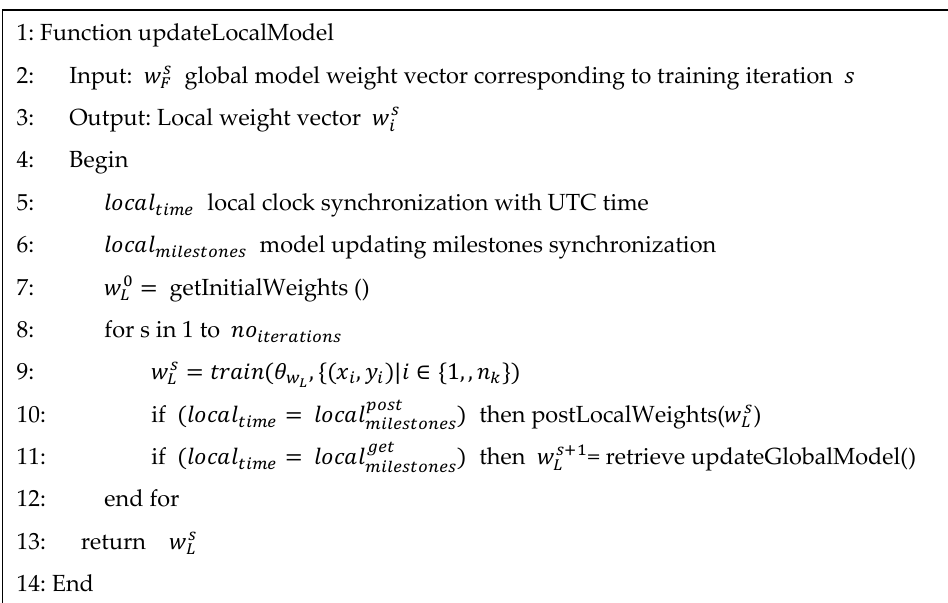
Figure 6. Updating the local ML models at edge prosumer nodes.